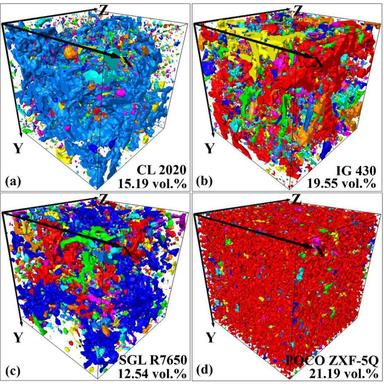
Porosity volume in four grades of graphite: (a) CL 2020 graphite, voxel size: 0.20 × 0.20 × 0.20 μm3, (b) IG 430 graphite, voxel size: 0.21 × 0.21 × 0.21 μm3, (c) SGL R7650 graphite, voxel size: 0.19 × 0.19 × 0.19 μm3 and, (d) POCO ZXF-5Q graphite, voxel size: 0.21 × 0.21 × 0.21 μm3. The total volume rendered for each graphite is 500 × 500 × 500 voxel3 identical, equivalent to a physical volume of approx. 0.001 mm3. Insert values are the total porosity within these volumes. Colours are for visual guidance a